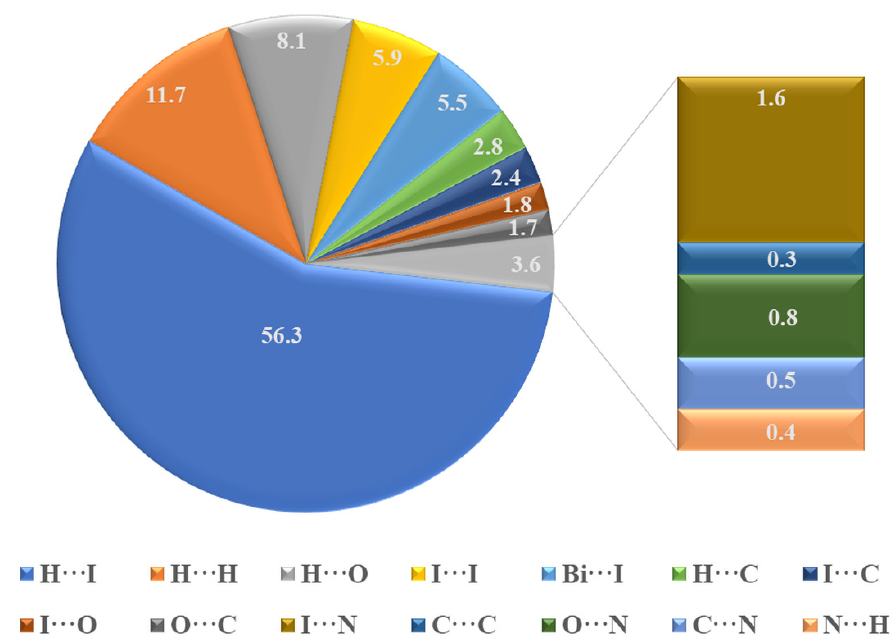
Figure 7. Relative contributions of different intermolecular contacts to the Hirshfeld surface area in Bi 4 I 16 ·4(C 6 H 9 N 2 ) 2(H 2 O). Table 4. Hirshfeld contact surfaces and enrichment ratios for Bi 4 I 16 ·4(C 6 H 9 N 2 )·2(H 2 O).